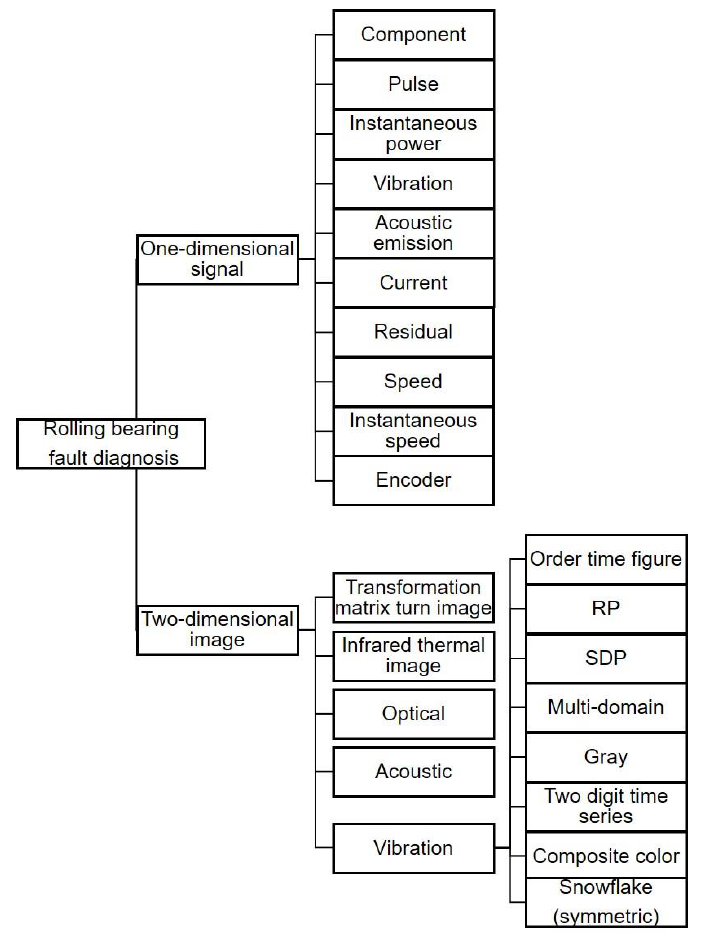
Figure 1. Diagram of the main content of this review.